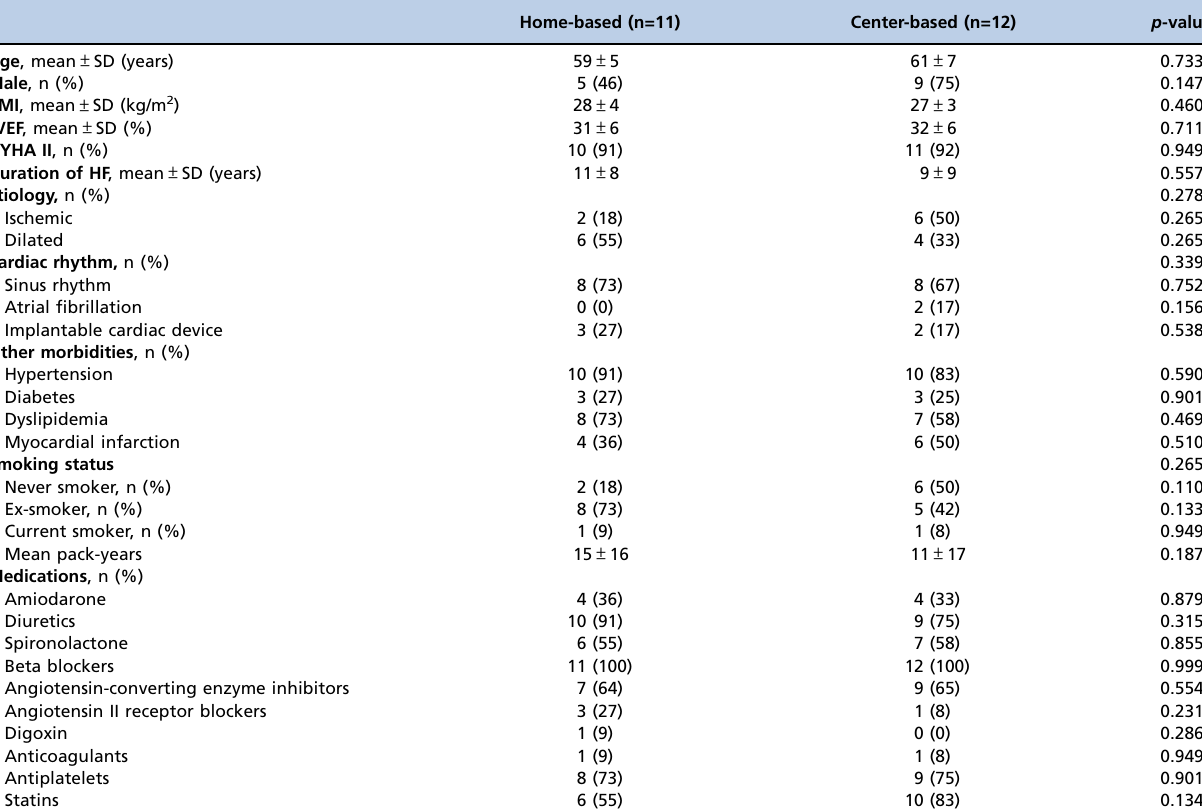
Table 1 - Demographic and clinical characteristics of home-based and center-based